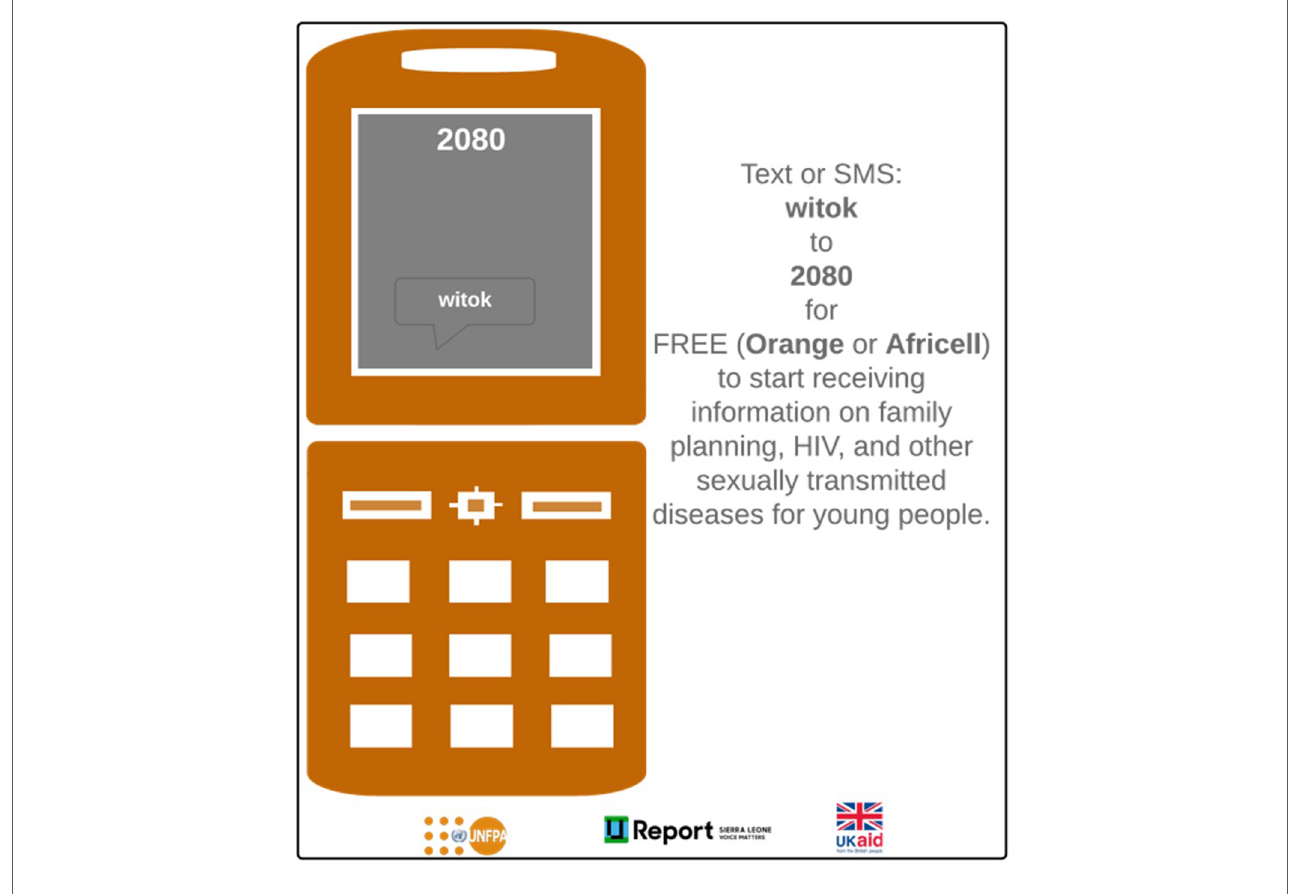
FIGURE 2 Proposed fl yer for advertising the short